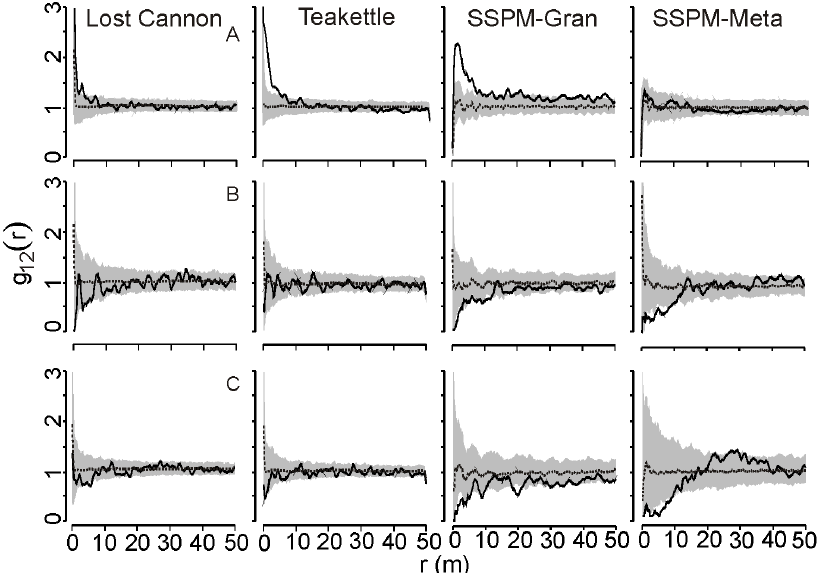
Figure 4. Bivariate pair correlation functions for all pairwise tree size classes (solid lines) from old-growth Jeffrey pine-mixed conifer forests. Size class comparisons are arranged in rows: A, 5–24 and 25–74 cm DBH; B, 25–74 cm and $ 75 cm DBH; and C, 5–24 cm and $ 75 cm DBH. The inhomogeneous pair correlation function with an Epanechnikov smoothing kernel was used for Lost Cannon and Teakettle. Approximately 95% Monte Carlo simulation envelopes (grey shaded areas) were constructed with the null model of independence.